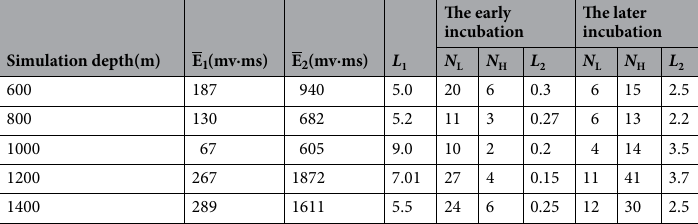
Table 3. Calculation results of L 1 and L 2 under different simulation depths.